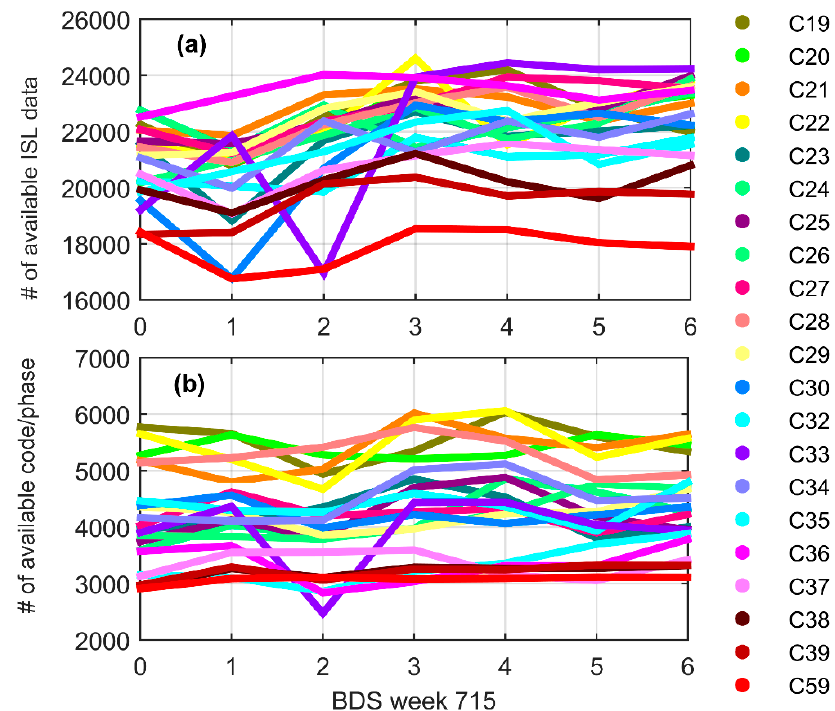
Figure 2. Number of available data in BDS Week 715: ( a ) the number of dual one-way ISL measurements, where outliers and single one-way observations that cannot form a dual one-way link are discarded; and ( b ) the number of code / phase measurements, where outliers and observations of short arcs less than 1200 s are discarded.